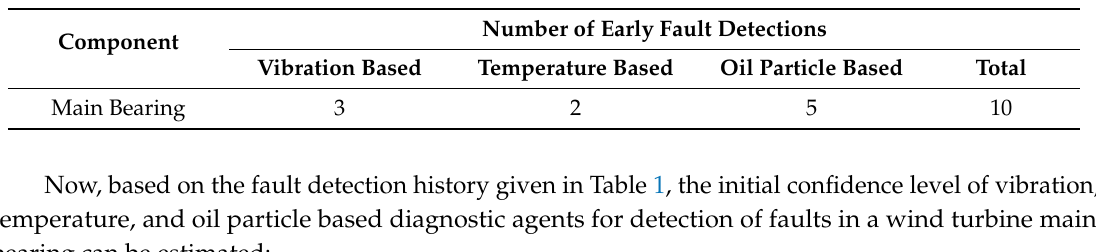
Table 1. Fault detection history of the main bearing used in this case study based on operational data of similar offshore wind farms.